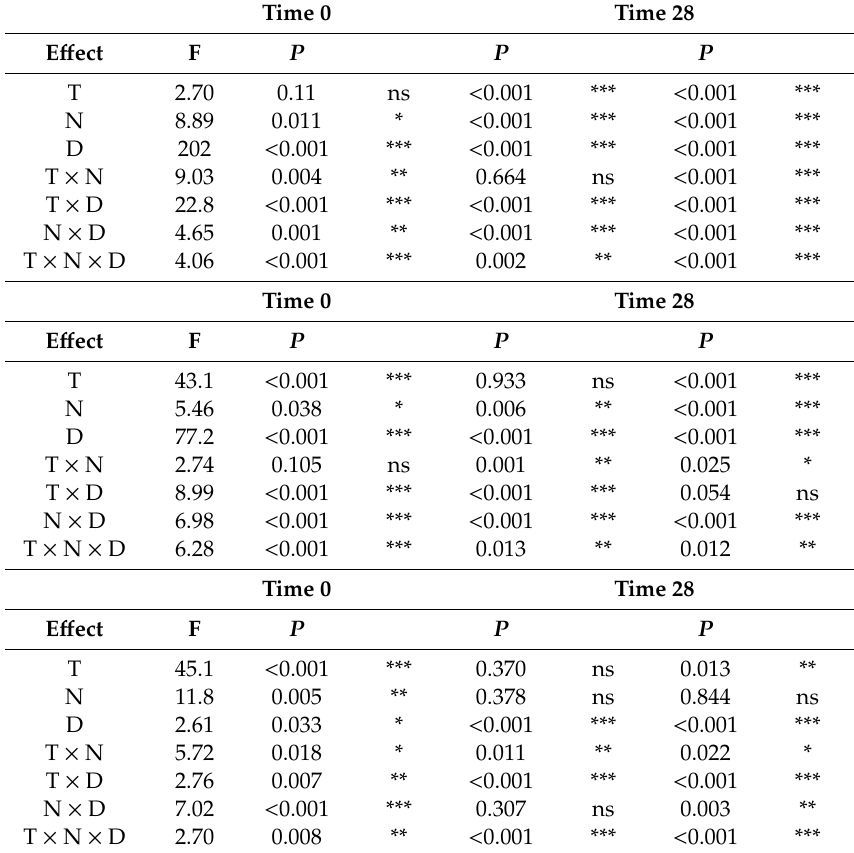
Table 3. Output of the ANOVA conducted on the data on ammonium, nitrate, and microbial N at time 0, 7, and